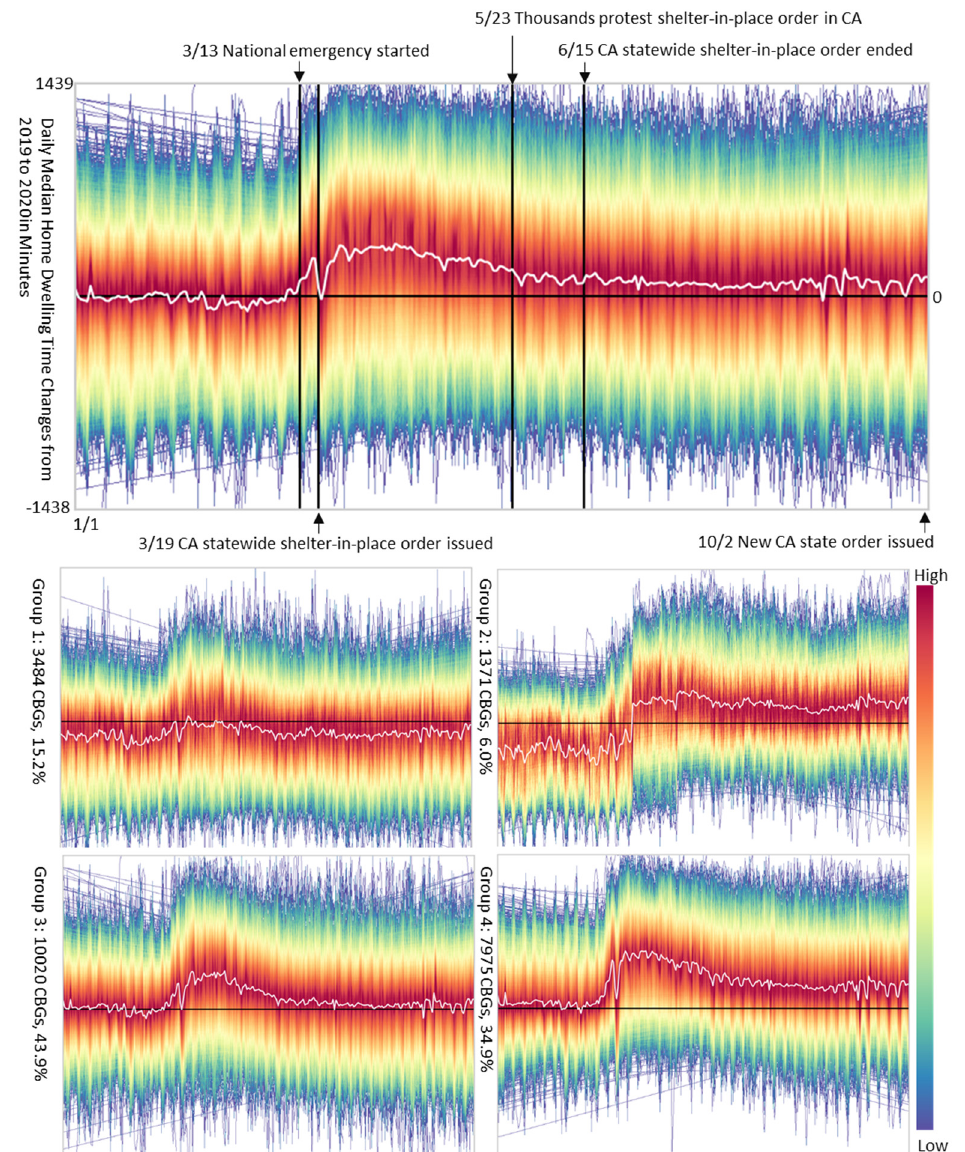
Figure 1. CBG level CA 2019–2020 daily median home dwelling time changes of the whole state and the four time ‐ HMP ‐ groups.